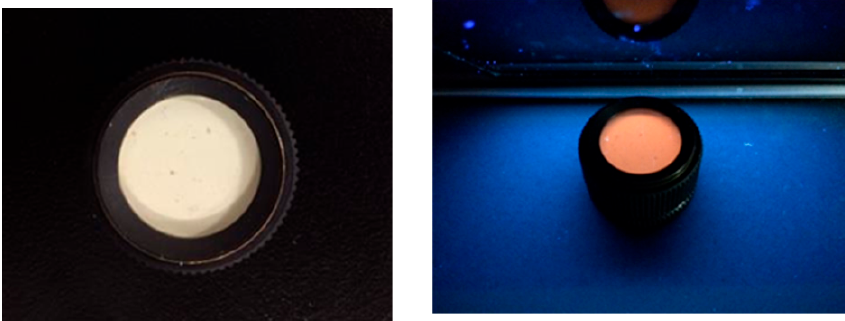
Figure 2. Image of the L-Cys / Au(I) complex without ( left ) and with ( right ) black light irradiation (wavelength 365 nm).